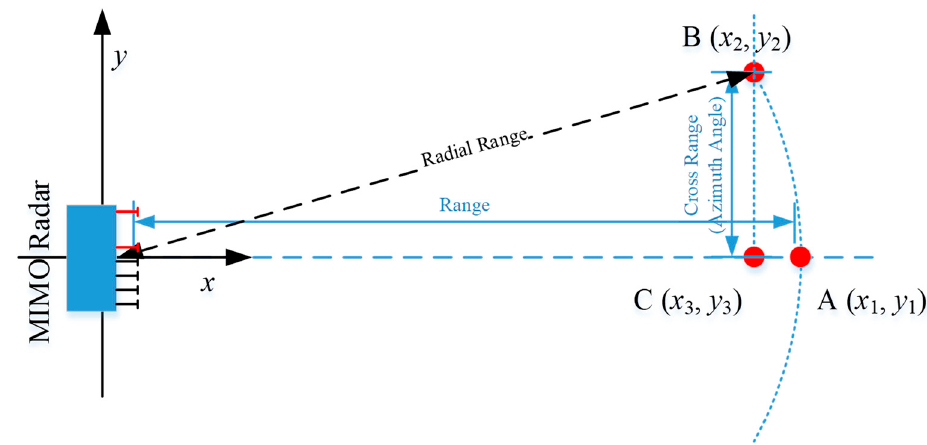
Figure 1. Multiple target deformation measurement with a MIMO interferometric radar.